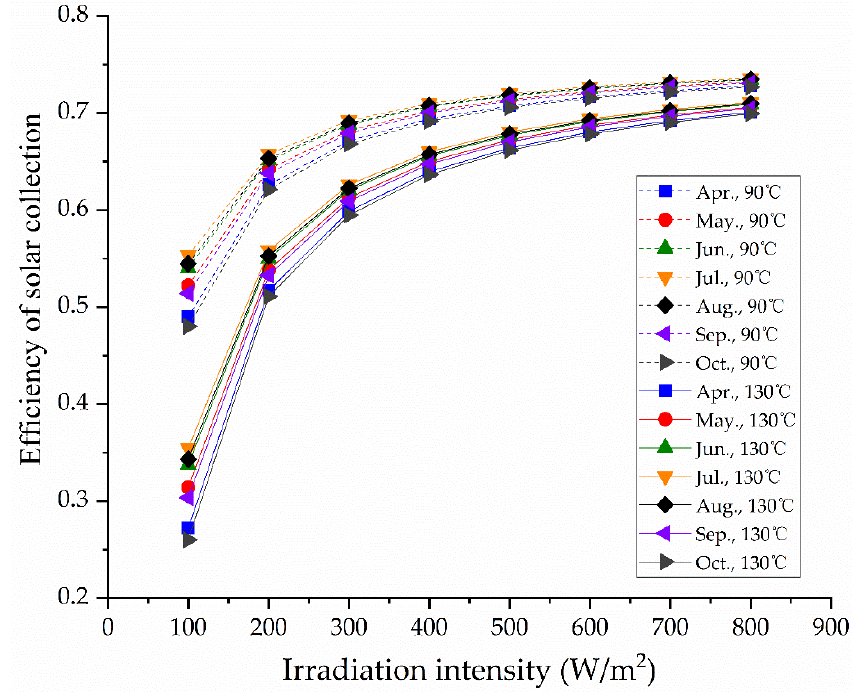
Figure 5. Variation of solar-energy collection efficiency in the non-heating season.